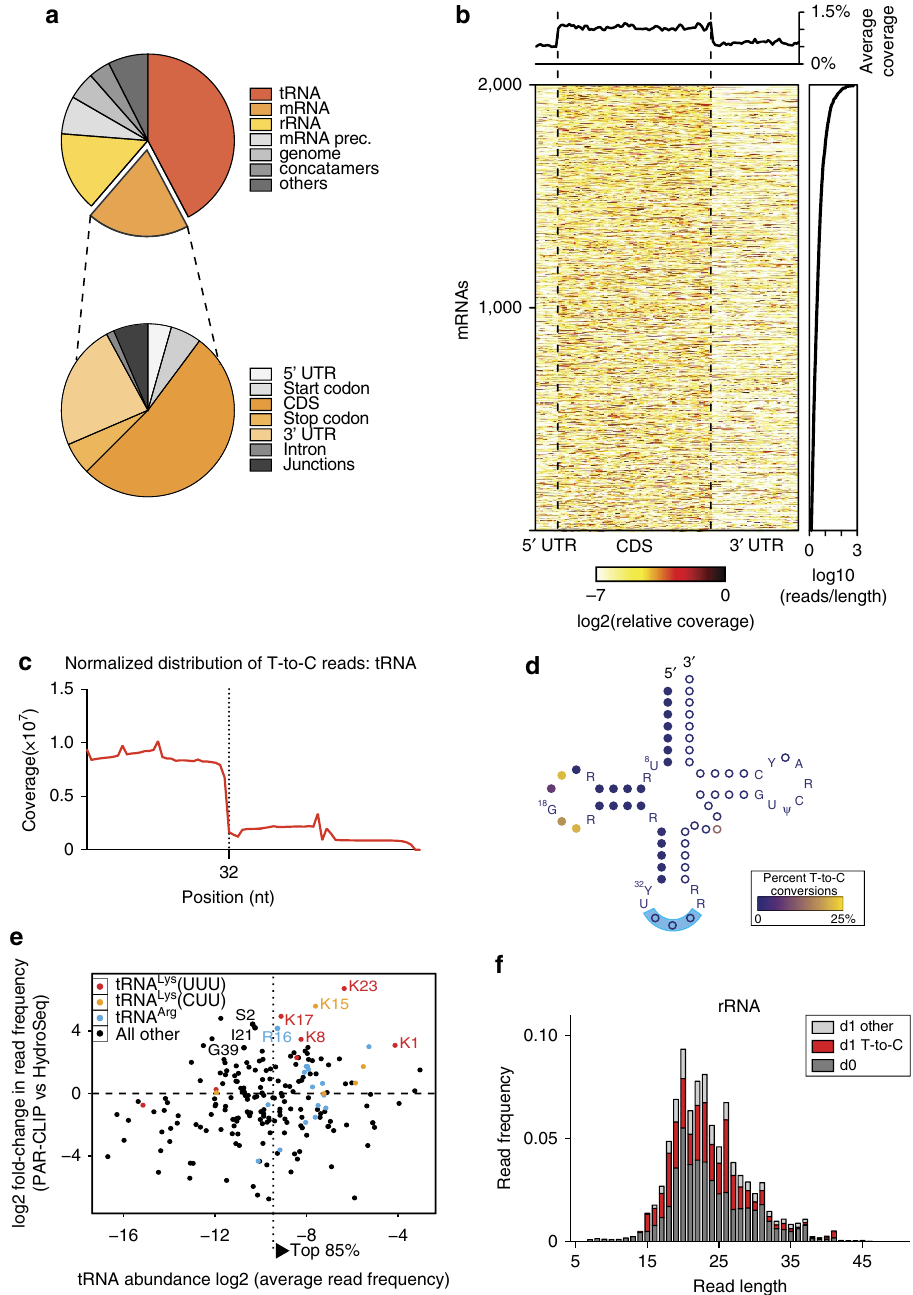
Figure 2 | PAR-CLIP RNA targets of ZNF598 in HEK293 cells. ( a ) Relative composition of ZNF598 PAR-CLIP sequence reads mapping to each RNA category with up to two mismatches. The reads mapped to nuclear encoded mRNAs are further subdivided into functional regions. ( b ) Meta-gene plot of PAR-CLIP reads mapping to mRNA defined by at least one read with T-to-C conversion. Each row in the matrix represents the relative coverage over each mRNA. mRNAs are ranked by the number of mapped T-to-C reads for the 3,000 most abundant mRNAs. The upper panel depicts the average coverage over the top 3,000 mRNAs. ( c ) Bin-normalized distribution of ZNF598 PAR-CLIP T-to-C reads mapping to tRNAs. ( d ) Schematic diagram of the secondary structure of tRNAs. Conserved nucleotides across cytosolic tRNAs are spelled out in letters, while non-conserved nucleotides are depicted by circles. The colour-code indicates the T-to-C conversion ratio. Filled circles at the 5 0 end represent nucleotides covered by ZNF598 PAR-CLIP sequence reads (32 nt of the 5 0 end). ( e ) Relative changes in tRNA abundance in ZNF598 PAR-CLIP versus HydroSeq (total cellular tRNA). All tRNA Lys (UUU) sequence variants are coloured in red, tRNA Lys (CUU) variants are coloured in orange, and all tRNA Arg variants are coloured in blue. tRNAs, which are over-represented in PAR- CLIP with a false discovery rate (FDR) of o 5% are labelled by their corresponding gene names. tRNAs collecting the top 85% of sequencing reads are to the right and residual tRNAs are to the left of the dotted vertical line. ( f ) Average read composition of two replicates of ZNF598 PAR-CLIP experiments for the rRNA category. Reads were assigned as d0 (dark grey), d1 T-to-C (red), d1 other than T-to-C and (light